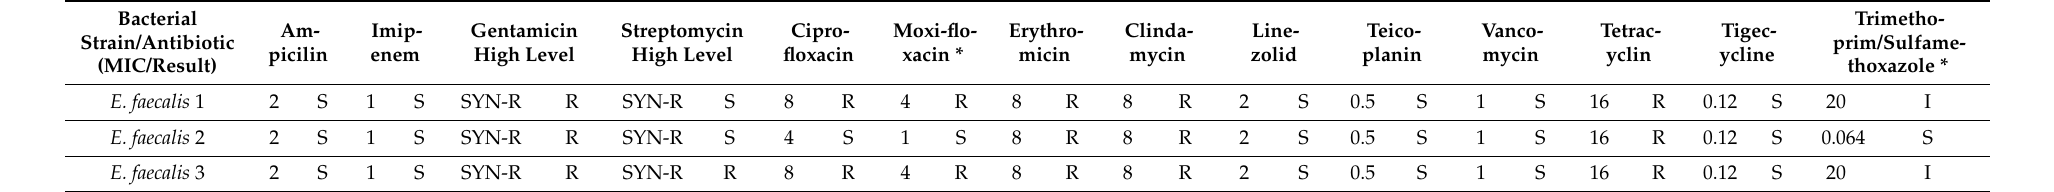
Table 6. MICs (mg/L) of antimicrobials for Enterococcus faecalis isolates. Bacterial Strain/Antibiotic